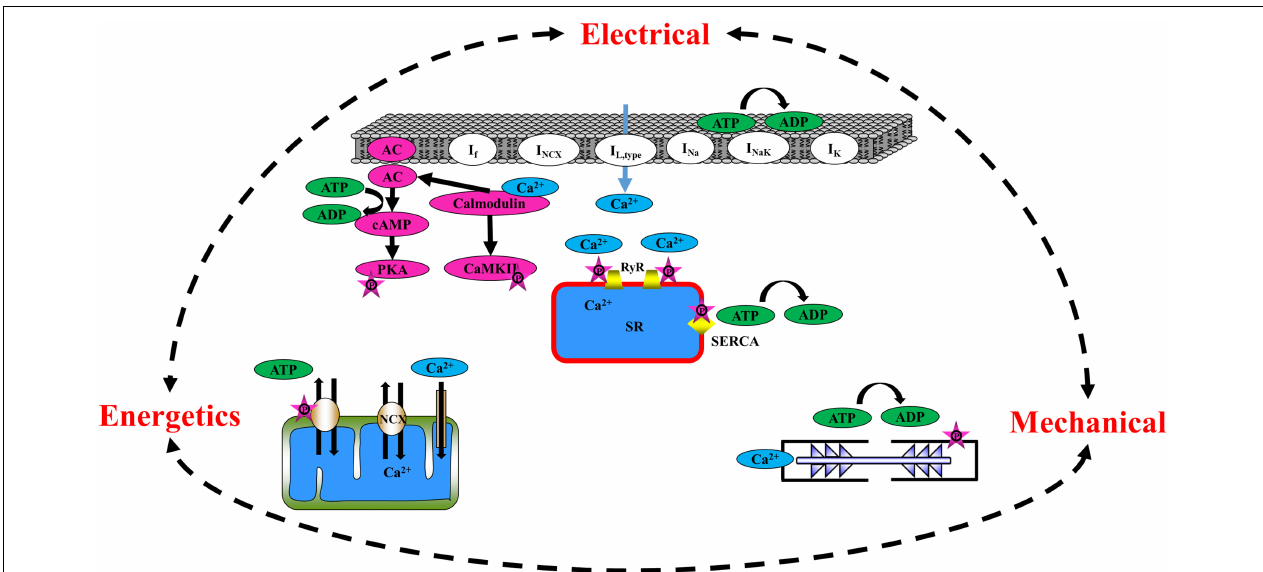
FIGURE 1 | Schematic illustration of the major players in mechano-electrical, mechano-Ca 2 + , and mechano-metabolic